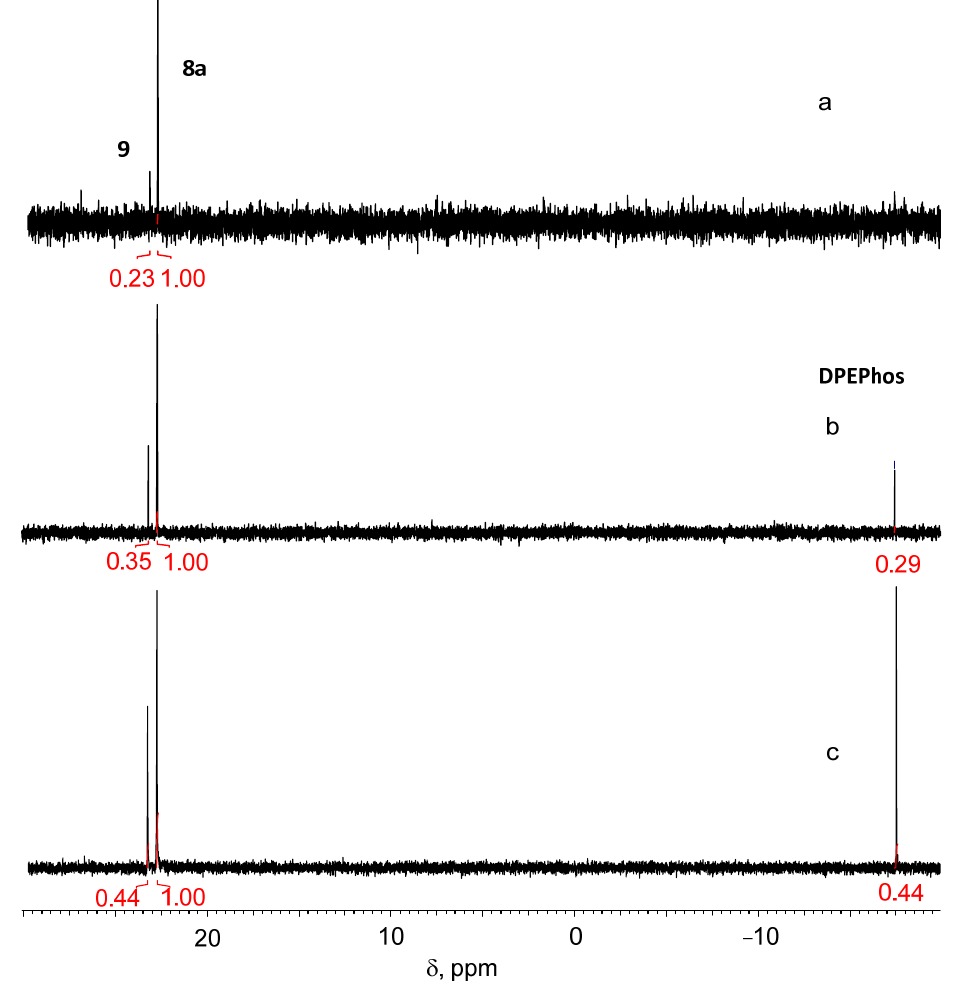
Figure 4. 31 P NMR spectra recorded for the reaction of complex 7 with isopropylamine just after mixing ( a) and after 24 h ( b ) or trimethylamine ( c ).